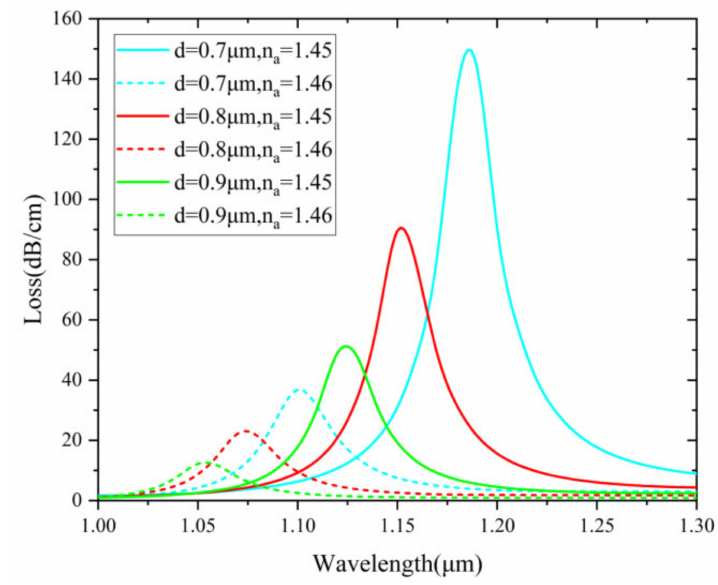
Figure 8. Loss spectra (n a = 1.45 and 1.46) for different d of 0.7, 0.8 and 0.9 µ